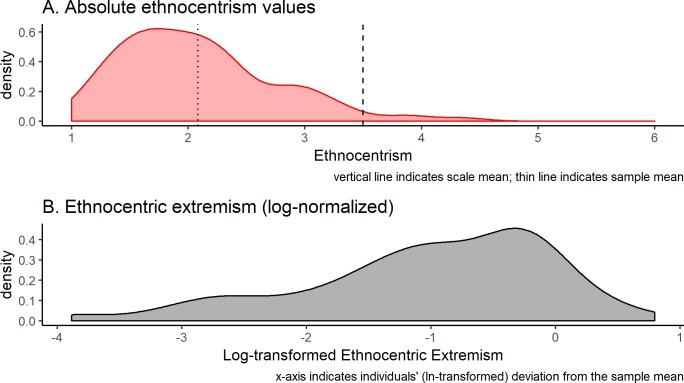
Distribution of ethnocentrism scores.(A) Absolute ethnocentrism values and (B) log-normalized deviations from sample mean.